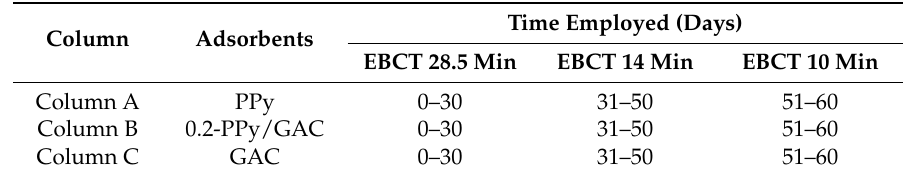
Figure 1. Schematic diagram of the laboratory column experiments showing the culture vessel ( A ); reactor with different adsorbents ( B ); and MTBE-containing (Methyl tert -butyl ether) solution vessel ( C ). The red line represents recirculation through the feeding vessel (closed mode operation), and the black line represents circulation through the column only (open mode operation). Both the vessel and reactor were maintained at 30 °C. Table 1. Laboratory column conditions.